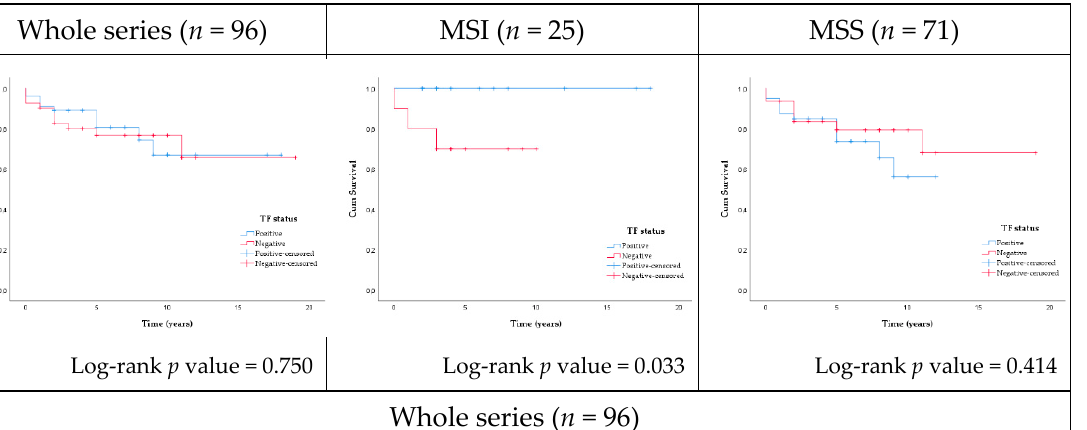
Table 2. Expression of TF antigen according to microsatellite instability (MSI) status.